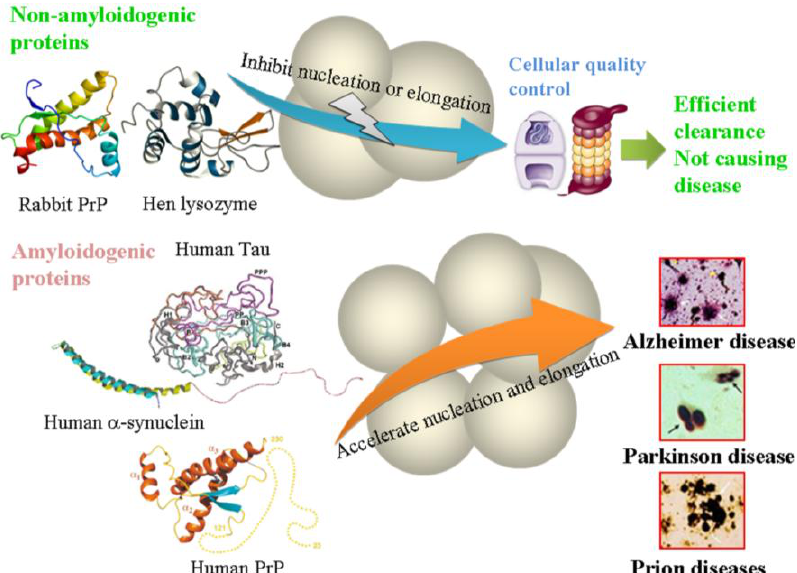
Figure 2. Regulatory mechanism of crowded physiological environments. The excluded-volume effects caused by macromolecular crowding could accelerate the aggregation of neurodegenerative disease-associated proteins while inhibiting the aggregation of the proteins that are not neurodegenerative disease-associated. The images of Alzheimer, Parkinson, and Prion disease aggregates are adapted from Figure 1 with permission from [72]. Copyright Nature Publishing Group,